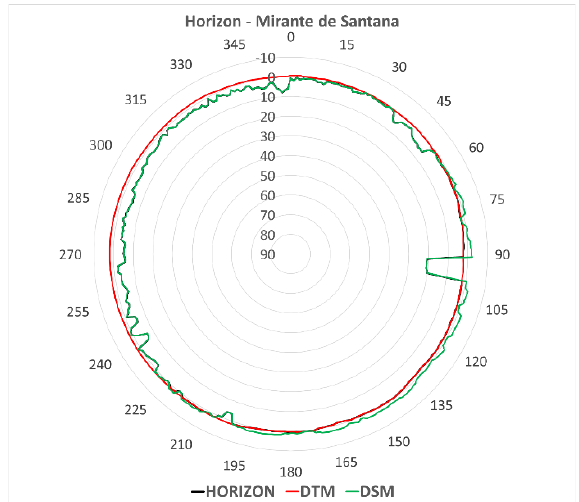
Figure 2. Horizon values from the weather station computed from the DTM and DSM. Azimuth and elevation angles in decimal